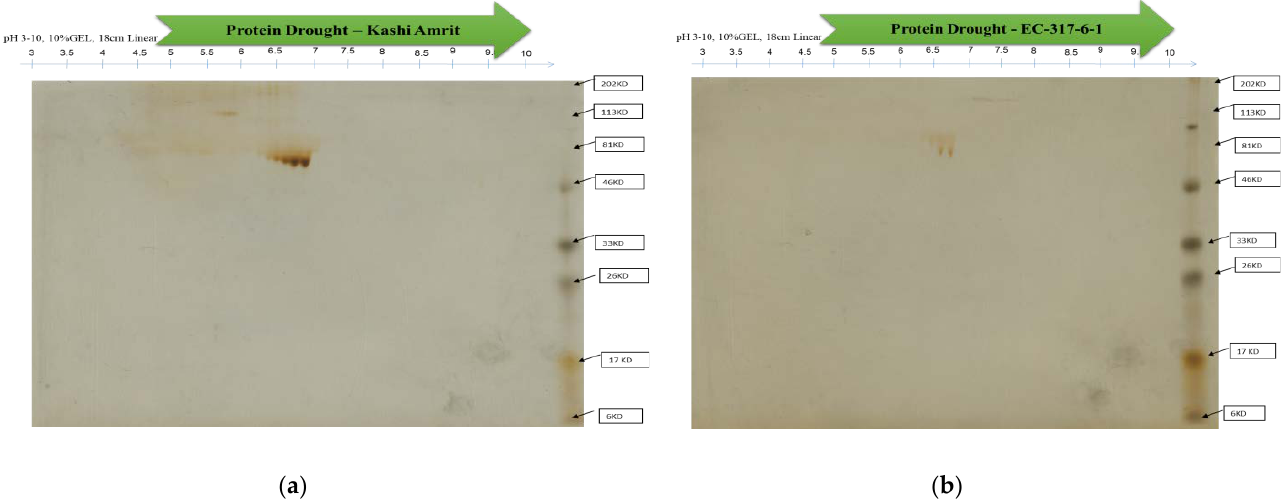
Figure 5. 2-D gel electrophoresis of proteins isolated from Kashi Amrit ( a ) and EC-317-6-1 ( b ) under drought conditions.